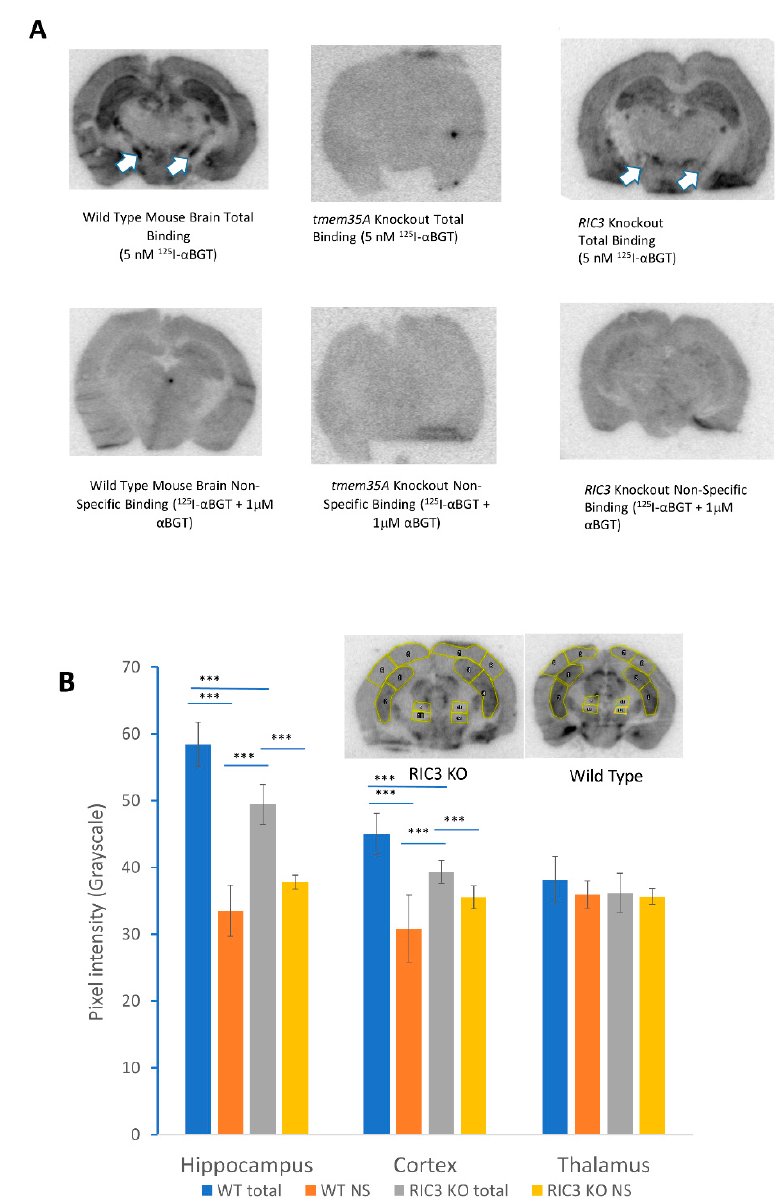
Figure 5. ( A ) Autoradiographic comparison of 125 I- α BGT binding between wild type and KO animal brain slices. Top row shows total binding for wild type (left), tmem35a KO (middle) and ric3 KO (right) brain sections. The bottom row shows corresponding non-specific binding. There was no specific binding in tmem35a KO, and significant loss of binding in specific brain structures in the ric3 KO brains (arrows). ( B ) Autoradiographic analysis of 125 I- α BGT binding using ImageJ. Significant loss of toxin binding was observed in the hippocampus and cortex of the ric3 KO compared to the corresponding structures in wild type (WT) animals (Specific binding is the difference between total binding and non-specific [NS] binding). The insets show typical sections and the areas used for analysis over two sections per condition (N = 8 areas per brain region, with a medial and lateral area for each brain side times two sections). This analysis was done on one experiment comparing one animal per condition since the two experiments performed so far were done using different batches of 125 I- α BGT with different specific activities and slightly different exposure times and are not easily comparable. Error bars represent standard deviations. *** p >0.001, (** p <0.01, * p <0.05) by single factor ANOVA.